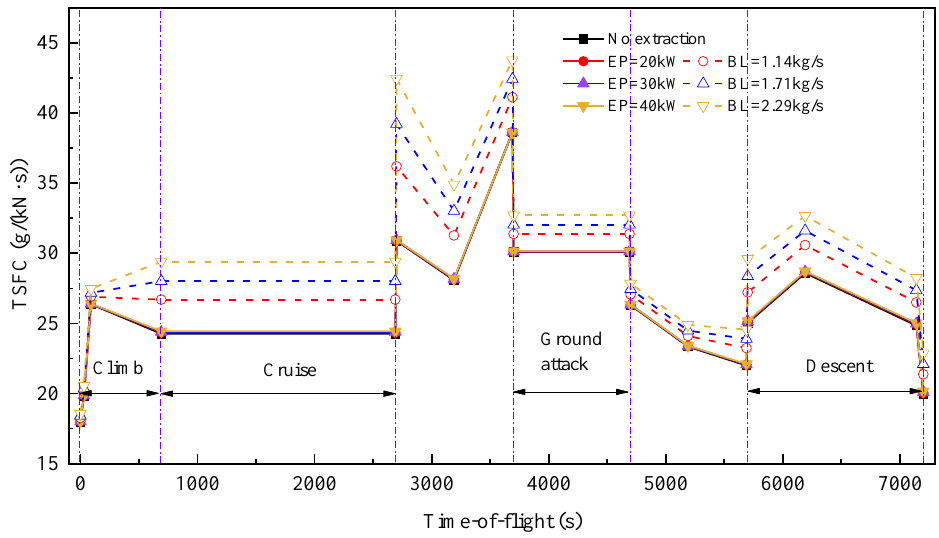
Figure 12. TSFC for each phase of the flight mission (EP, electric power extraction; BL, bleed air). From Figure 12, the TSFC is high when the fighter jet is in the station of altitude cruise or descending. In the case of the climb, the difference between the two strategies is relatively small. In addition, the TSFC caused by the vapor cycle is significantly smaller than that of the air cycle. Compared with no power extraction, the TSFC of the air cycle is increased by at least 2%, while it is almost negligible for the vapor cycle.